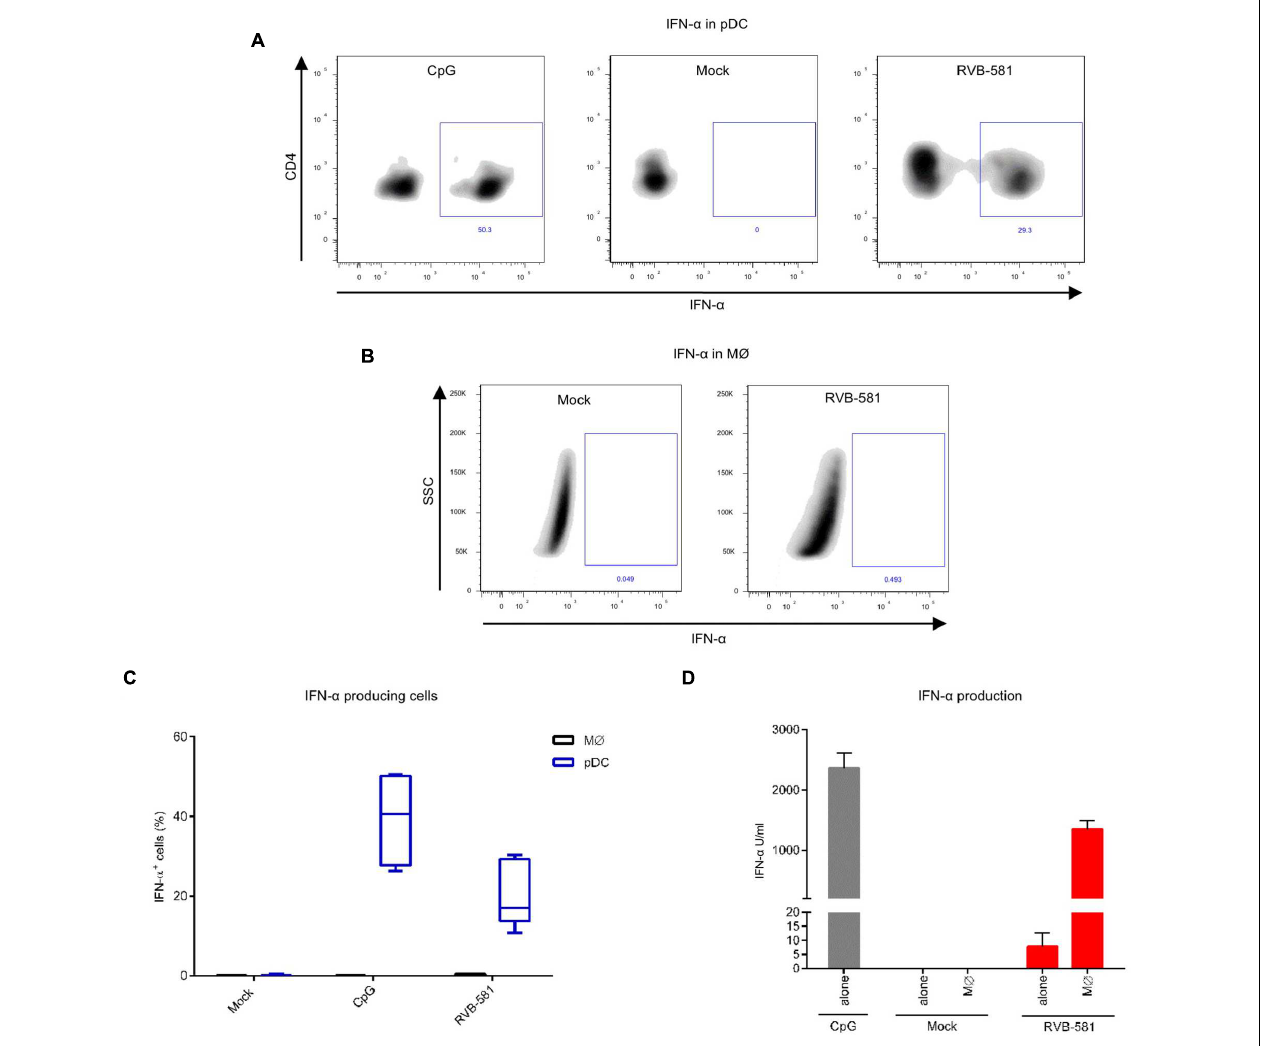
FIGURE 3 | IFN- α production is restricted to pDC during co-culture with PRRSV-infected MØ. MØ were infected with PRRSV RVB-581 for 90 min, washed and then co-cultured with enriched pDC. Mock-treated MØ and CpG D32 stimulation were included as negative and positive controls, respectively. (A) Intracellular IFN- α staining of pDC (gated as CD172a low CD4 + cells) after CpG stimulation or co-culture with PRRSV-infected MØ. (B) Intracellular IFN- α staining of MØ (CD172a + CD4 − cells), harvested from the same co-culture as in (A) . (C) Boxplots made from nine replicates collected from three independent experiments